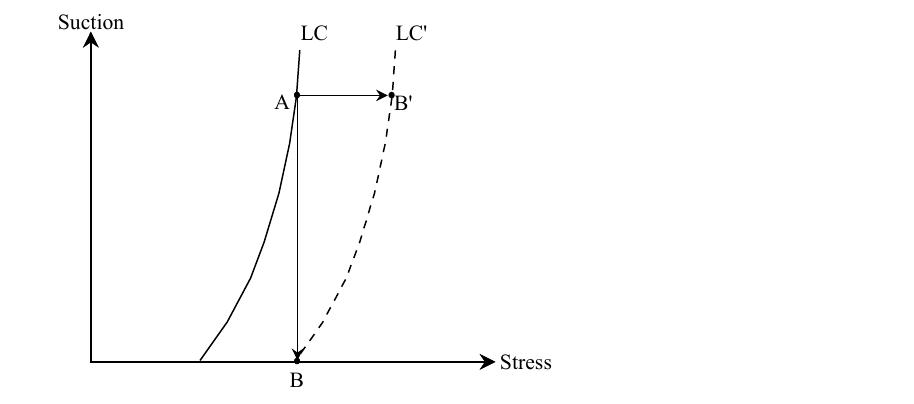
Figure 11. The collapse strain induced by the suction ‐ decrease path. AB: suction reduction path, AB’: loading path.